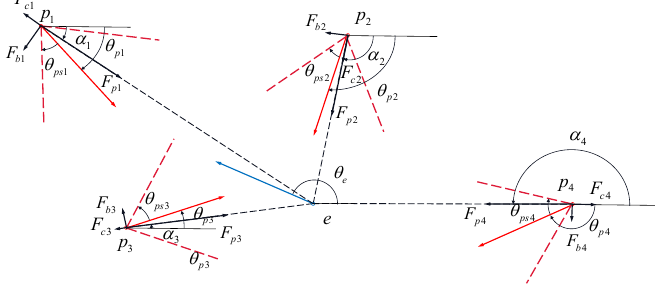
Figure 6. Virtual-force-analysis diagram of the i -th